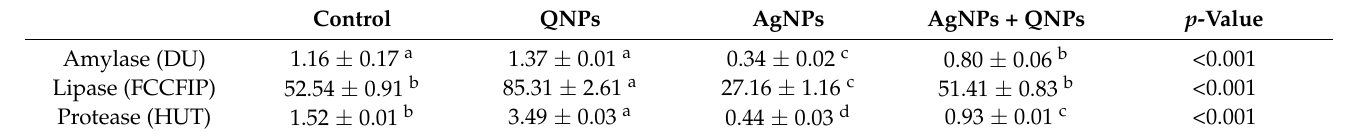
Table 5. Effect of QNPs on intestinal enzyme activity in AgNPs-induced toxicity in Nile tilapia.